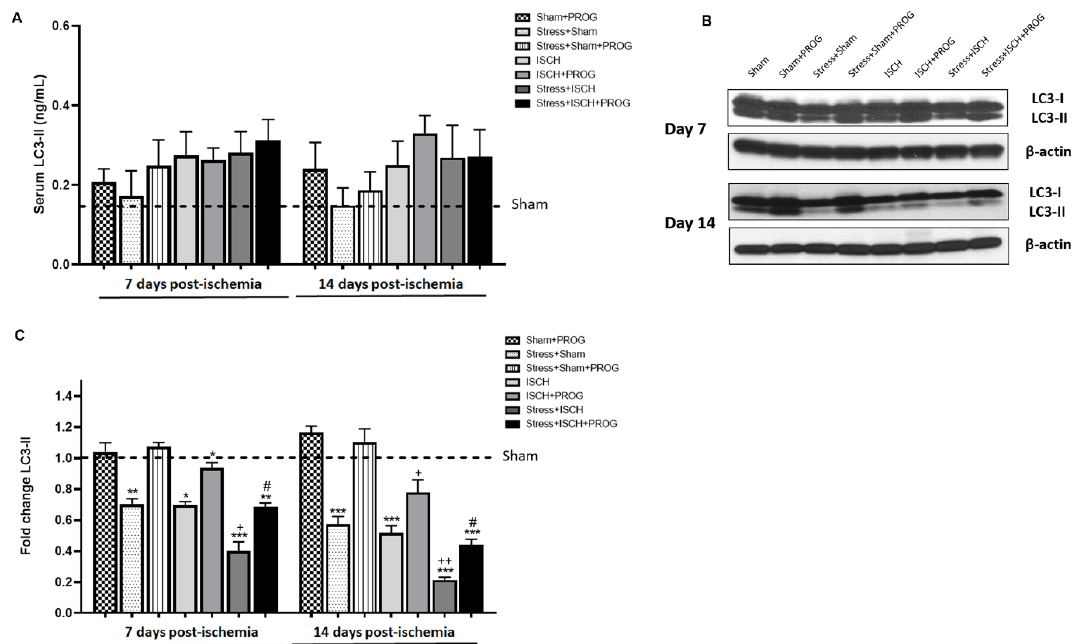
Figure 4. Effects of stress and progesterone on autophagy following global ischemia. ( A ) Levels of LC3-II in serum [ANOVA F(15, 80) = 0.8303, p < 0.6417], ( B ) representative blots and ( C ) densitometry data for LC3-II in the hippocampus [ANOVA F(15, 80) = 40.60, p < 0.0001], obtained from ischemic animals at 7 and 14 days after global ischemia, or from sham animals. Data are expressed as mean ± SEM. N = 6 / group. * p < 0.01, ** p < 0.001, *** p < 0.001 vs. Sham; + p < 0.05, ++ p < 0.01, +++ p < 0.001 vs. ISCH; and # p < 0.001 vs. STRESS +